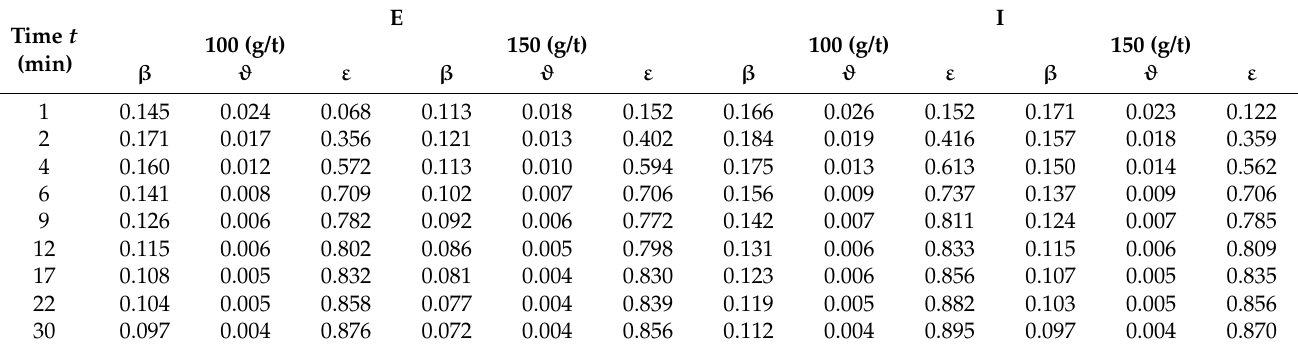
Table 3. Results of measurements for particle size fraction 0–20 ( µ m).